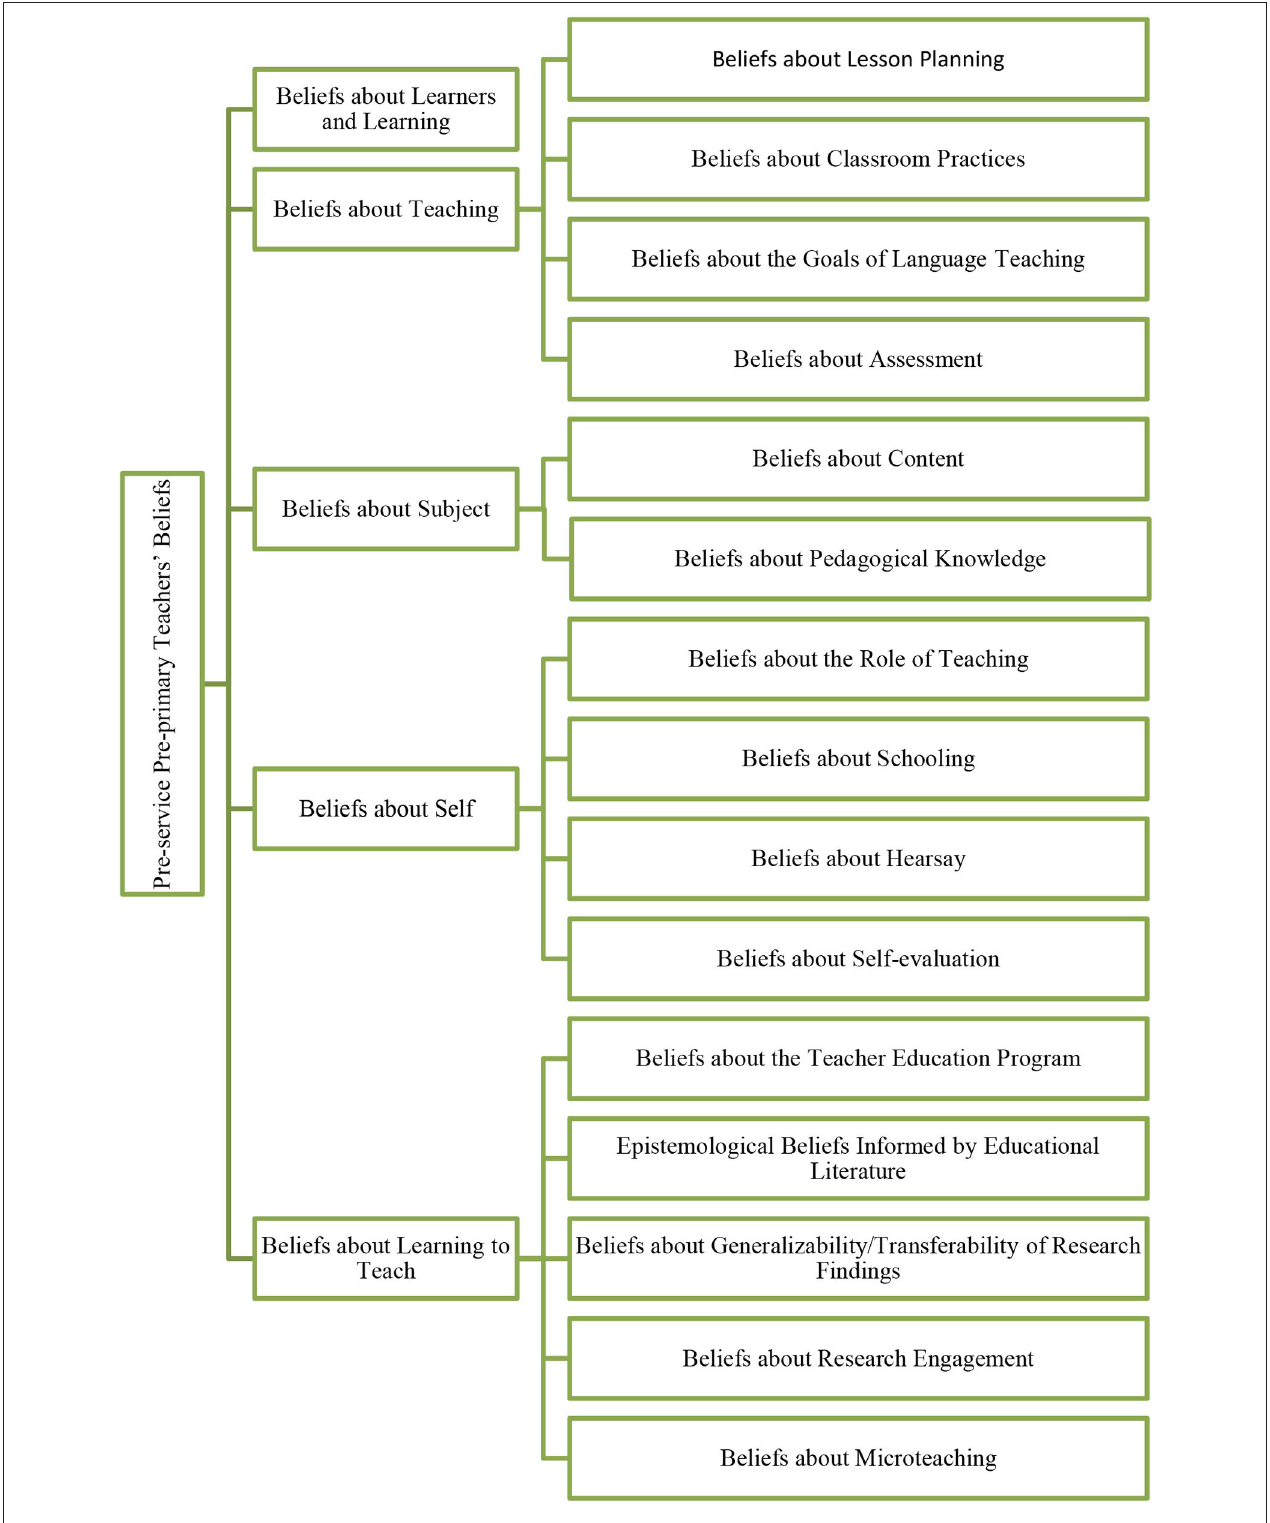
FIGURE 2 | Pre-service pre-primary teachers’